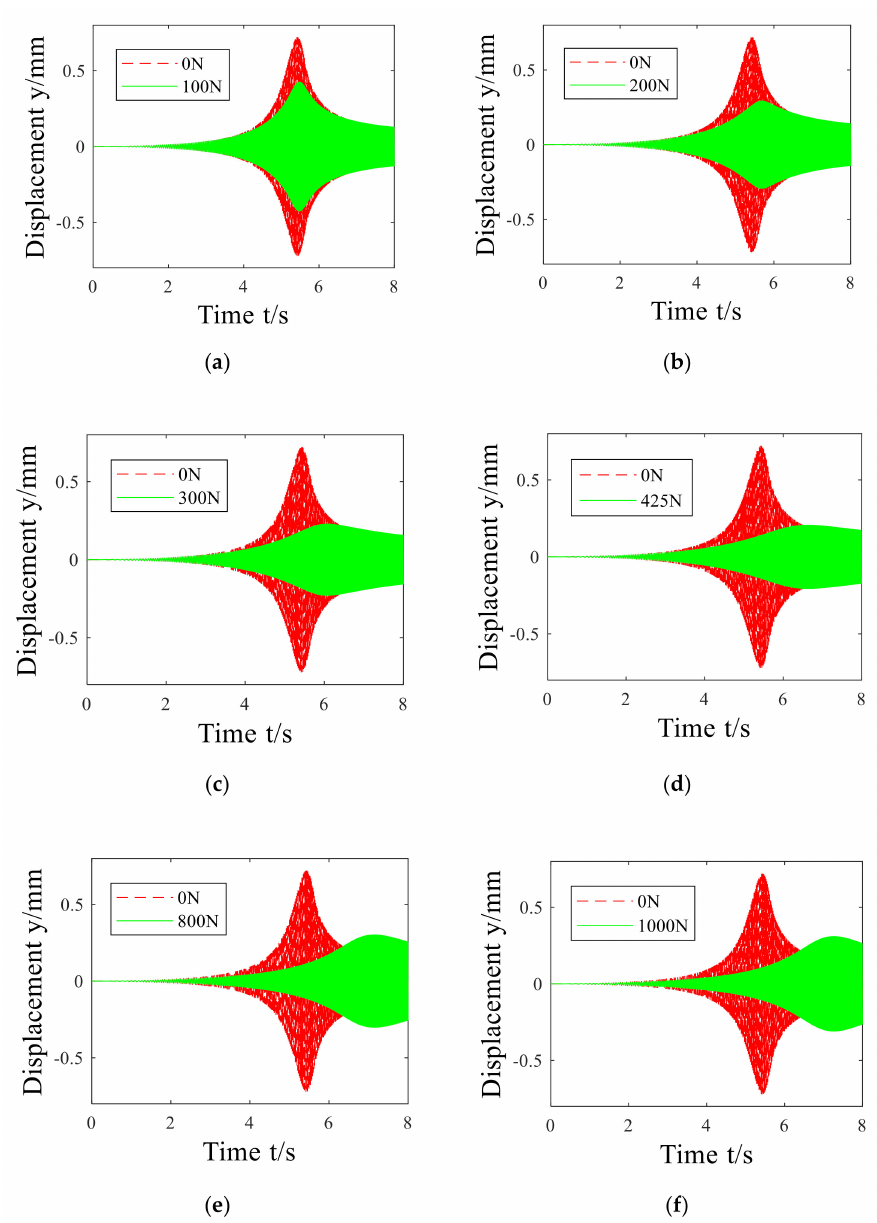
Figure 7. Response of the shaft system under ( a – f ) fixed control forces, respectively 100 N, 200 N, 300 N, 425 N, 800 N and 1000 N of the Smart